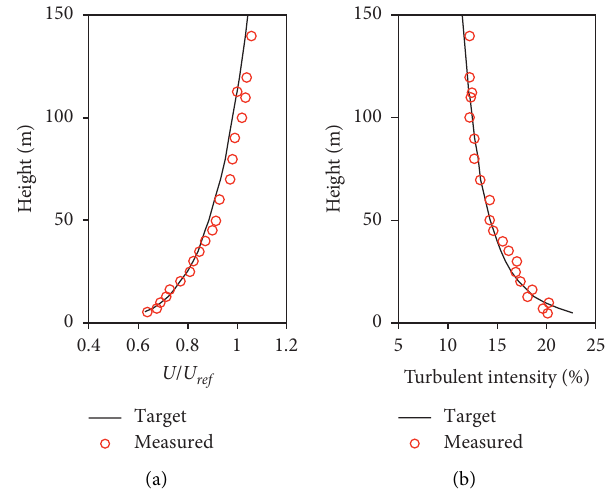
Figure 6: Boundary layer wind profile in the test section. (a) Mean wind velocity. (b) Turbulent intensity.